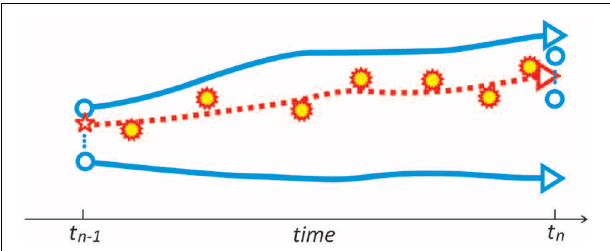
unfilled circles to the left represent the range of the ensemble of analyses at time t n − 1 ; the full blue lines represent the range of ensemble forecasts using the ensemble of analyses at t n − 1 as the initial states; the dashed red line represents a linear combination of the forecasts (using the red star as the initial state) used to provide the final state—the analysis, at time t n . The red stars filled in yellow color represent the observations used during the assimilation window. The blue unfilled circles to the right represent the range of the ensemble of analyses at time t n used for the next assimilation window. The spread of the ensemble members represents the forecast error. Based on material in Kalnay